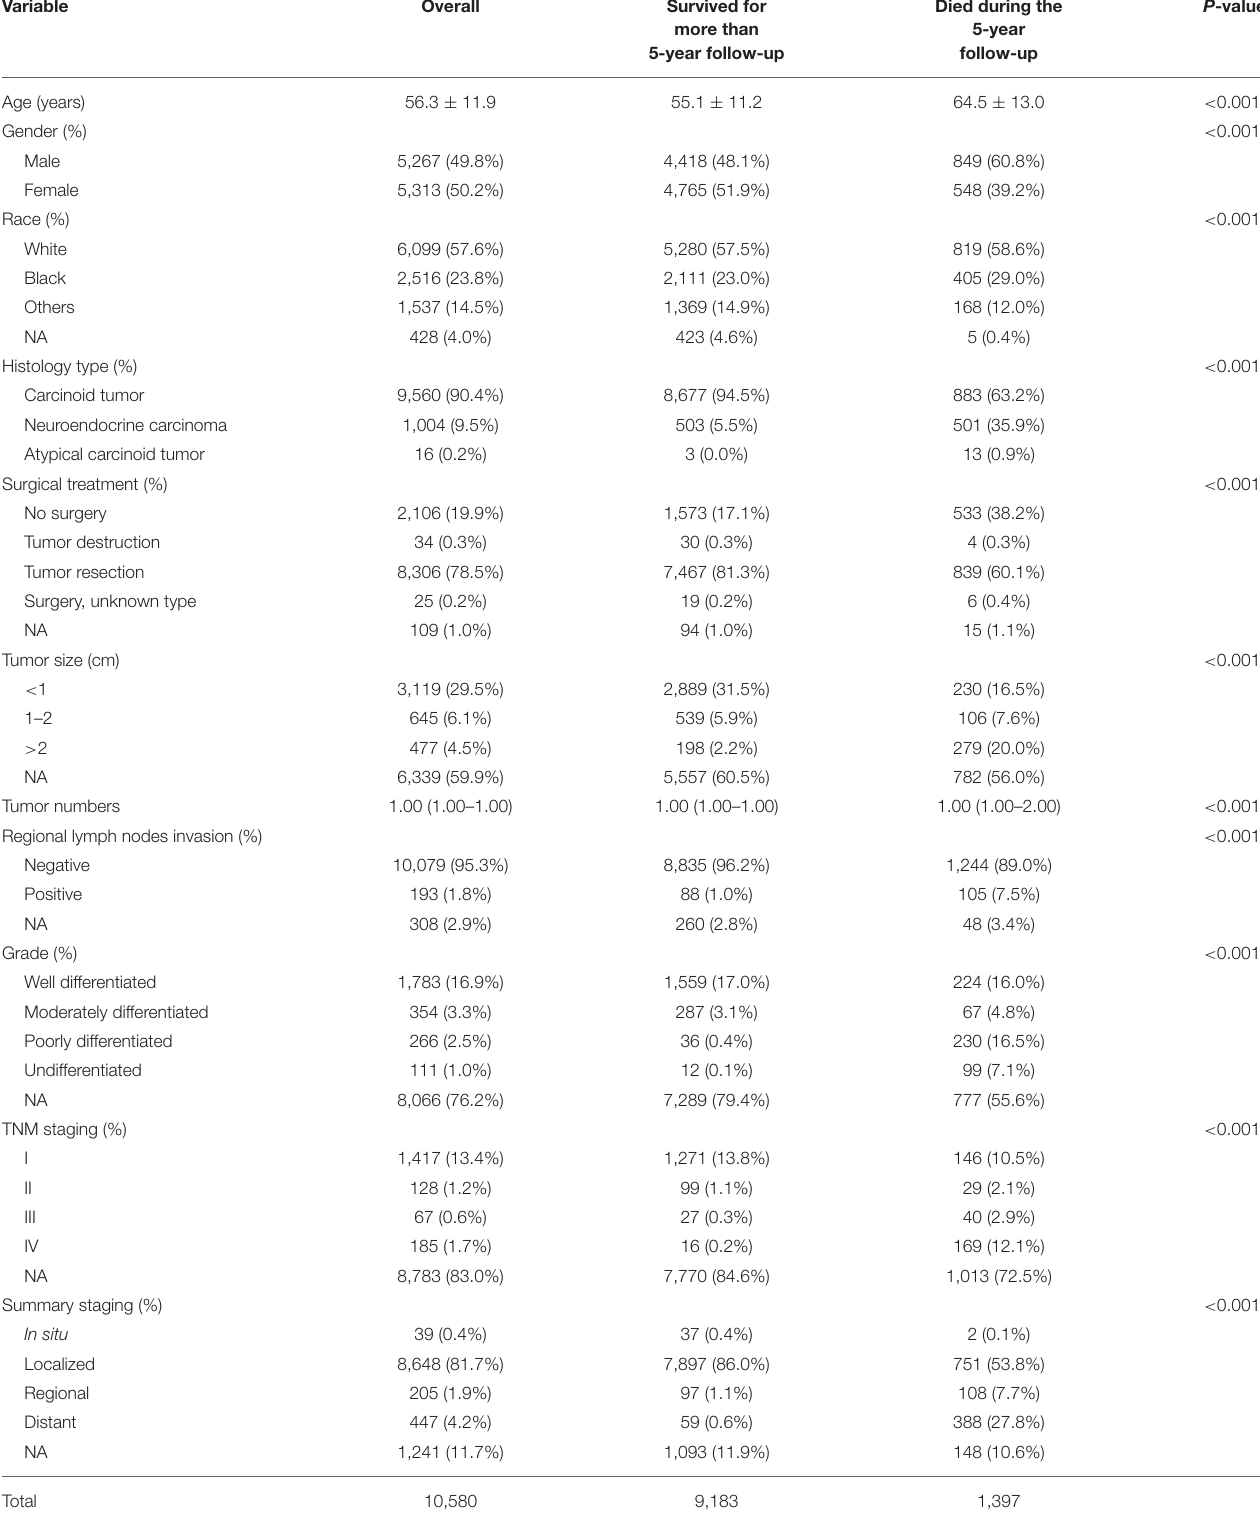
TABLE 1 | Main characteristics of the